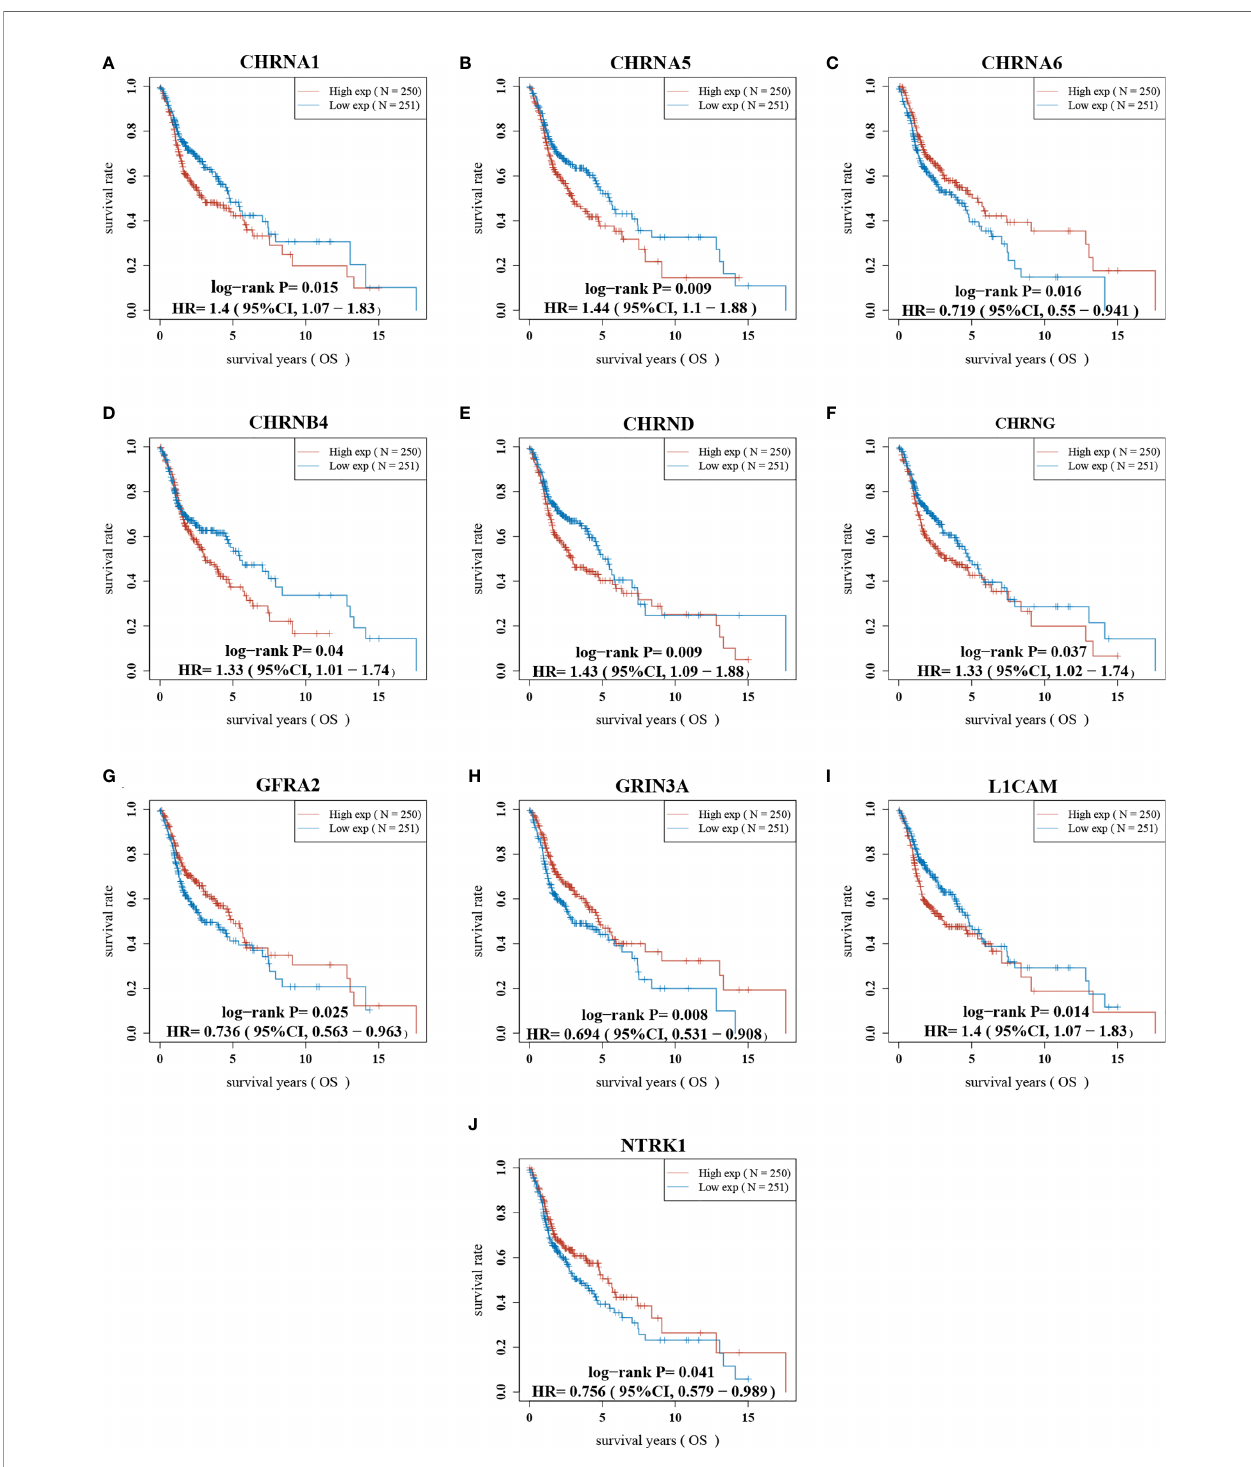
FIGURE 3 | The prognostic value of NCCGs in HNSC. The overall survival of CHRNA1 (A) , CHRNA5 (B) , CHRNA6 (C) , CHRNB4 (D) , CHRND (E) , CHRNG (F) , GFRA2 (G) , GRIN3A (H) , L1CAM (I) , and NTRK1 (J) in HNSC patients in the high/low-expression groups. NCCGs, nerve-cancer cross-talk genes; HNSC, head and neck squamous cell